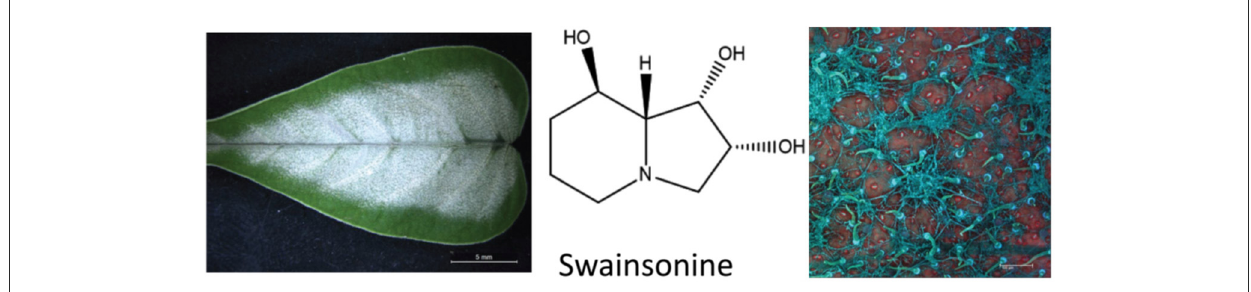
FIGURE6 Ectopic growth of the Chaetothyriales fungal symbiont that produces swainsonine on Ipomoea carnea